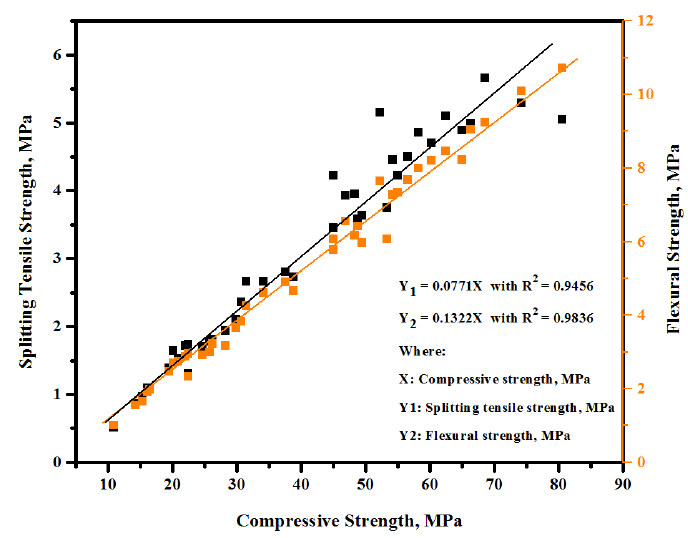
Figure 9. Correlation between compressive strength, flexural and splitting tensile strength of GPMs specimens.